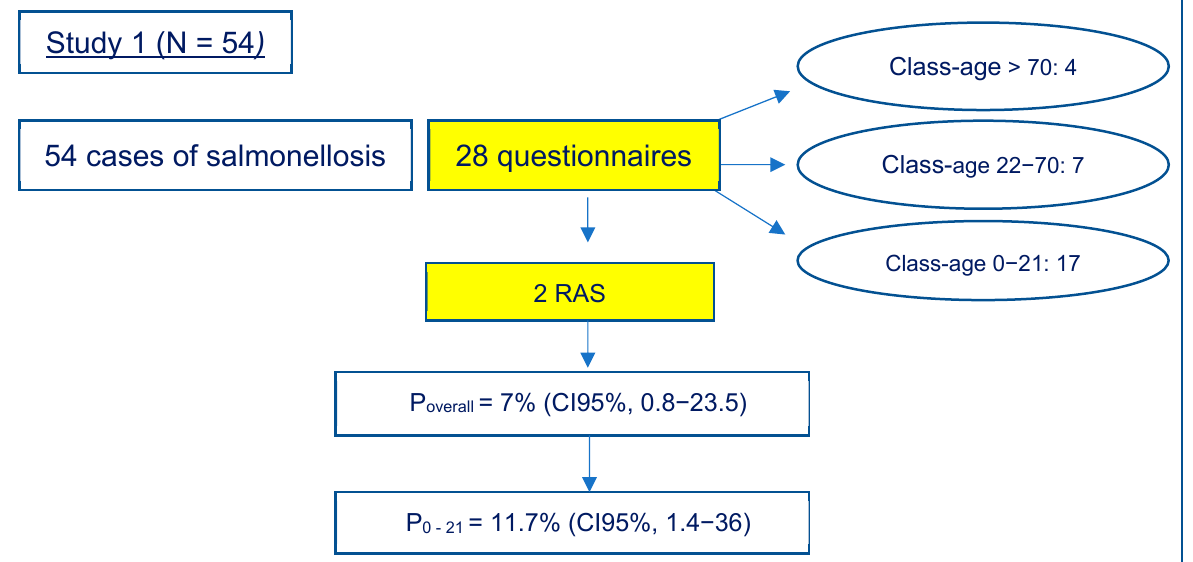
Figure 1. Results of the study carried out at the Hospital “Citt à della Salute e della Scienza” of Turin,